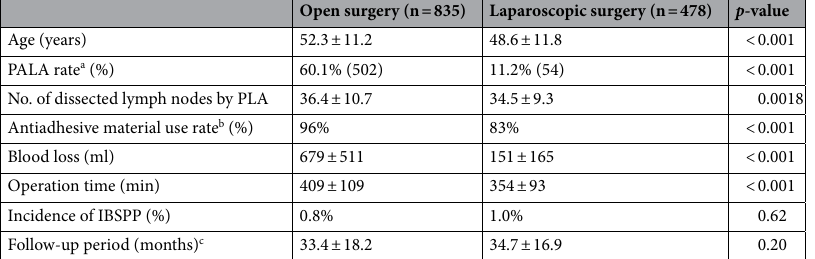
Open surgery (n = 835) Laparoscopic surgery (n = 478) p